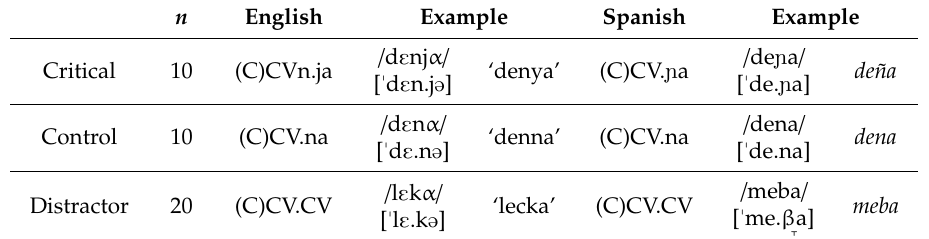
Table 3. Composition of nonce stimuli in the English and Spanish delayed repetition tasks. n